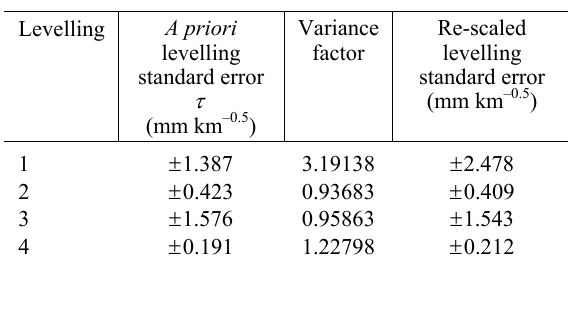
Table 5. Results of the variance component estimation using the Helmert, Bique and Förstner methods. All methods ultimately led to the same result, except for the number of the iterations (Helmert and Bique = 14 iterations, Förstner =